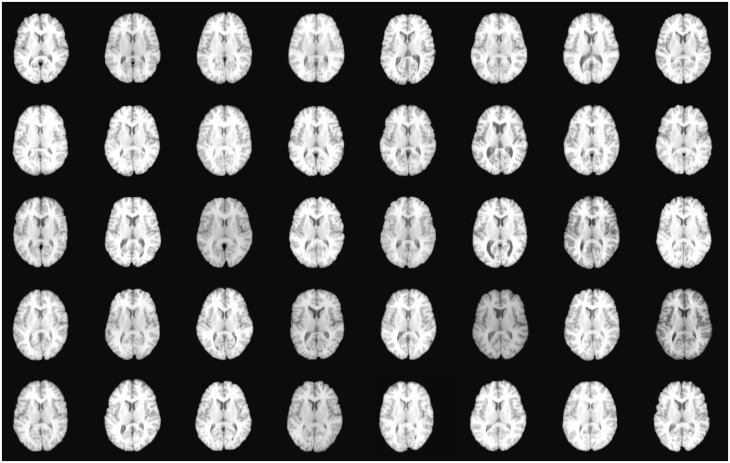
40 LONI MR images.